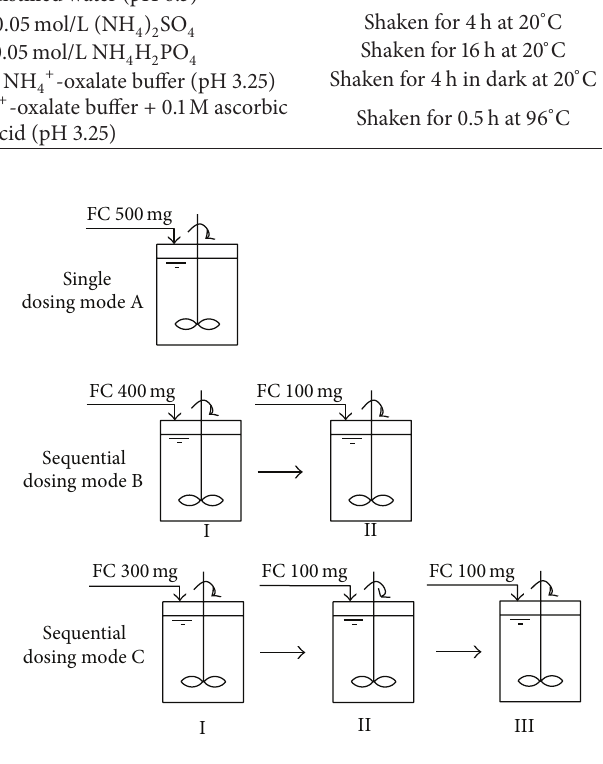
Figure 1: Dosing modes for the jar